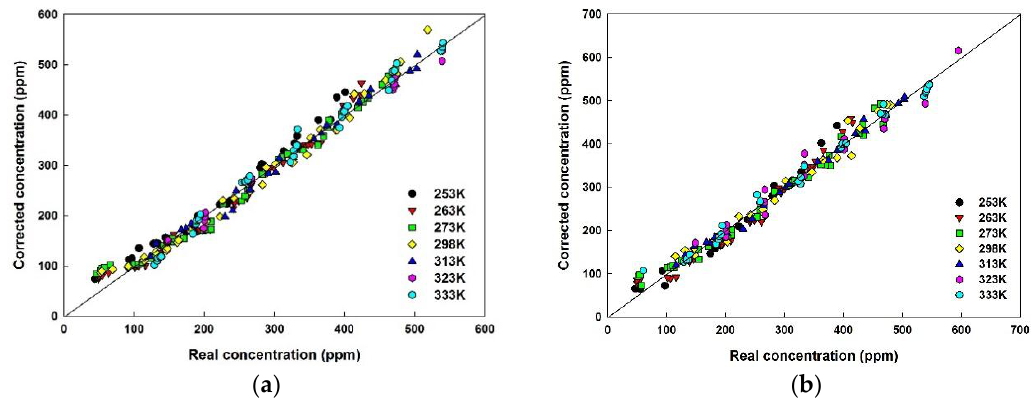
Figure 10. Corrected concentration of Parylene-C module at ( a ) detector end with no disk (2.0 Ø ); ( b ) detector end with hollow disk (1.6 Ø ).